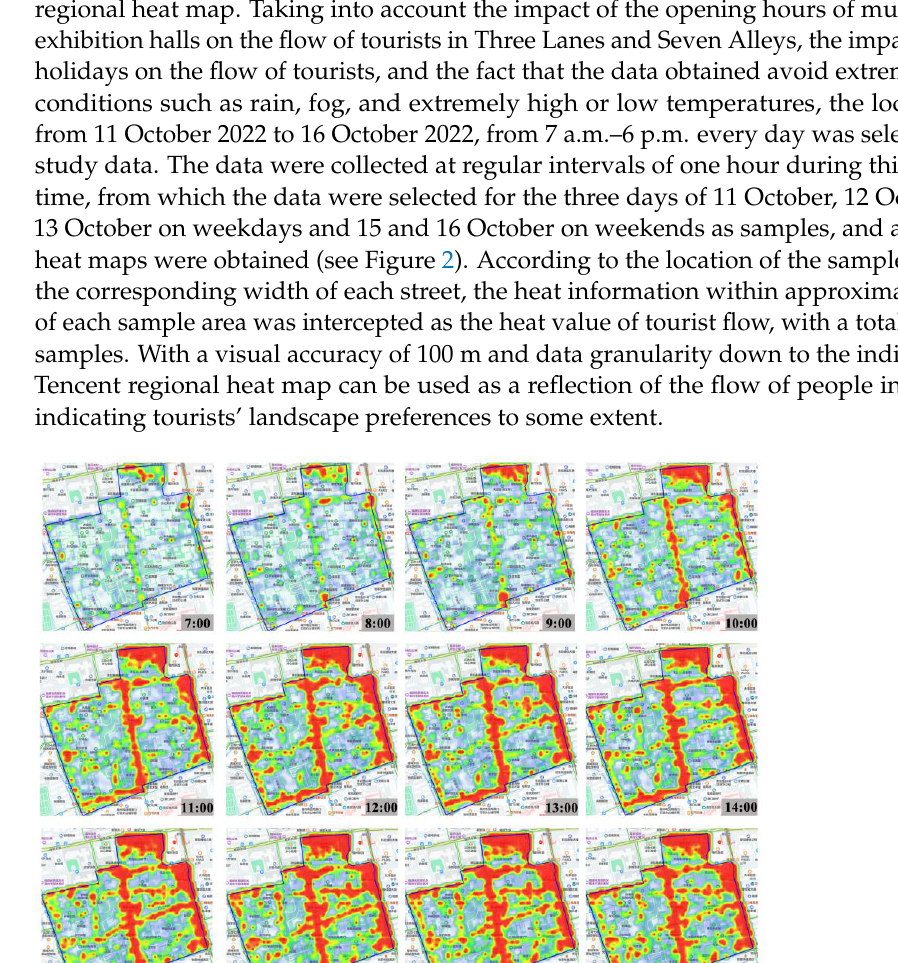
Table 1. The scores corresponding to the different colors of the heat map. Color of Heat Map